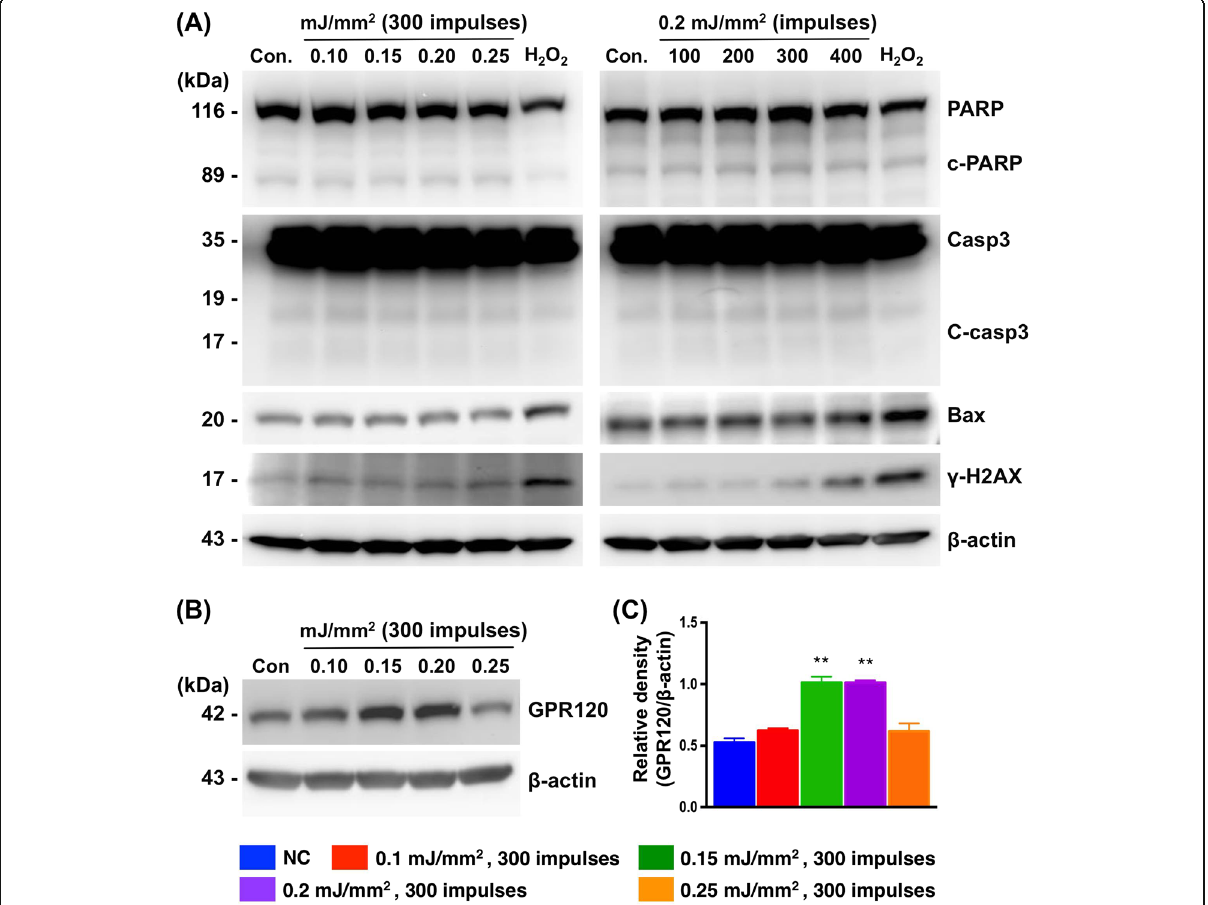
Fig. 1 Upregulation of GPR120 by extracorporeal shock wave treatment (ESWT) in human urothelial RT4 cells. a Expressions of apoptosis-related proteins in RT4 28 h post-ESWT assessed by immunoblotting, including cleaved-PARP (c-PARP), cleaved-caspase 3 (c-casp 3), Bax, γ -H2AX. H 2 O 2 (500 μ mol/L) treatment used as positive control. b Optimal energy and frequency of ESWT for GPR120 upregulation. c Densitometric quantification of GPR120 in RT4 without (i.e., Con.) or with ESWT. β -actin used as internal control for immunoblotting. Values expressed as the mean ± SD of three independent experiments. * p < 0.05, ** p < 0.01 vs. control; Significance of differences determined by one-way